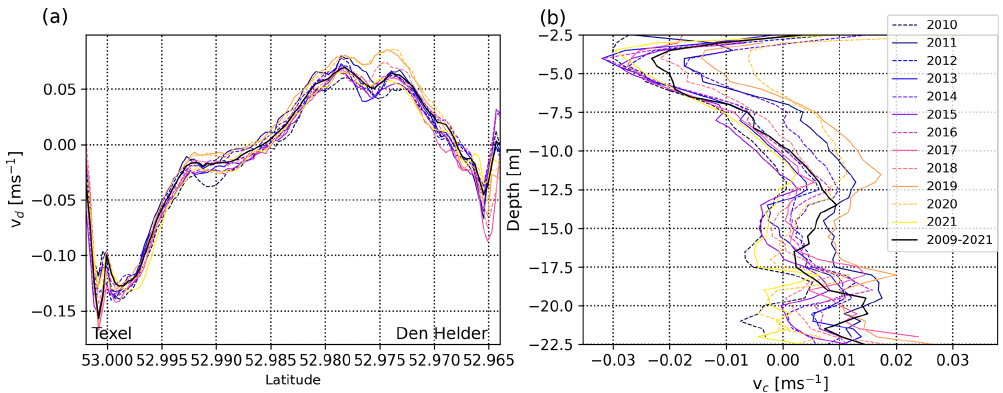
Figure 8. (a) Depth-averaged eastward residual velocities along the transect and (b) cross-sectionally averaged eastward residual velocities as a function of depth for each year and for the whole time